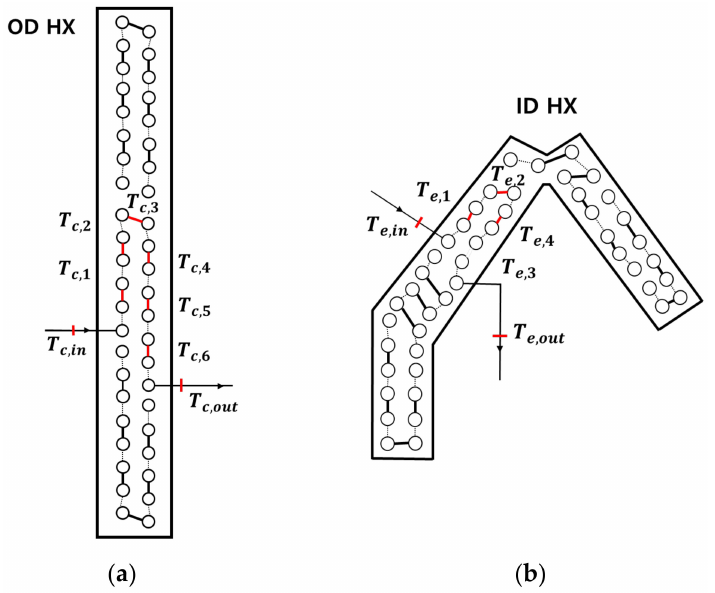
Figure 2. Positions of thermocouples for measuring heat exchanger temperature; ( a ) Condenser, ( b )